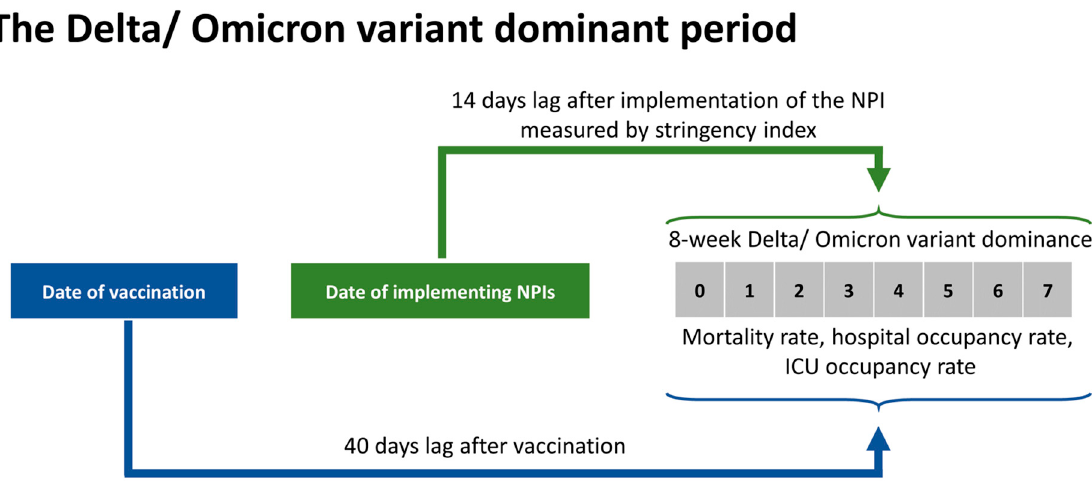
Figure 1. Time lag effects of vaccination and NPIs during study periods.